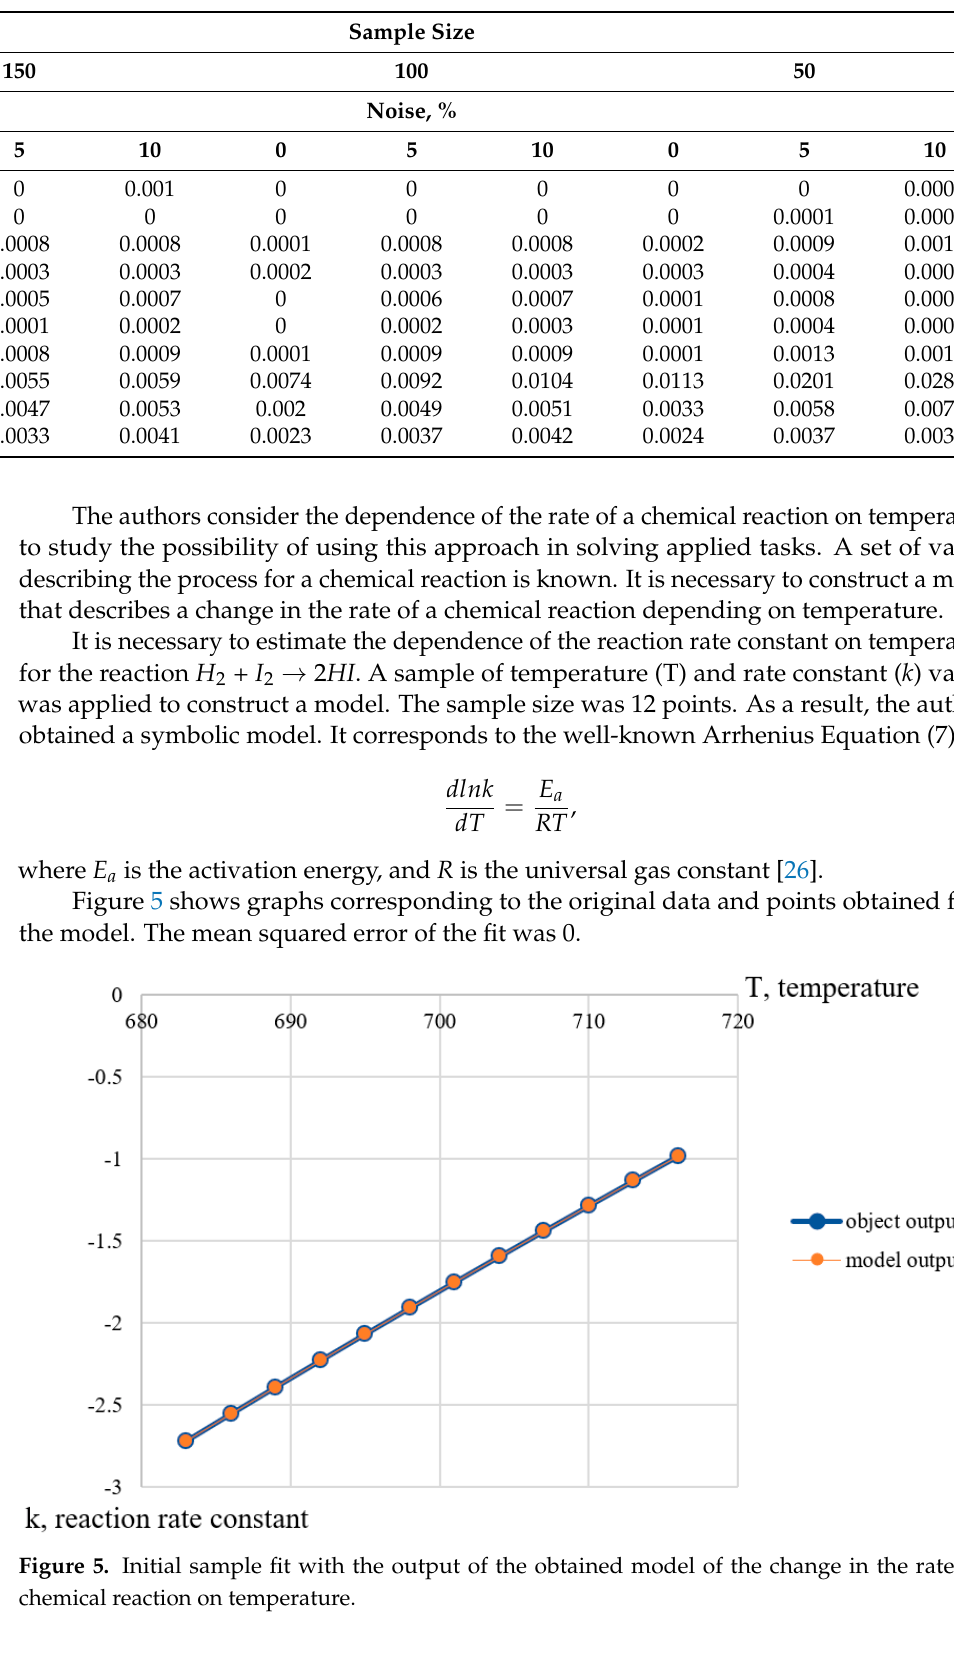
Table 2. Testing results of the evolutionary approach to the identification of dynamical systems in the form of an ODE.